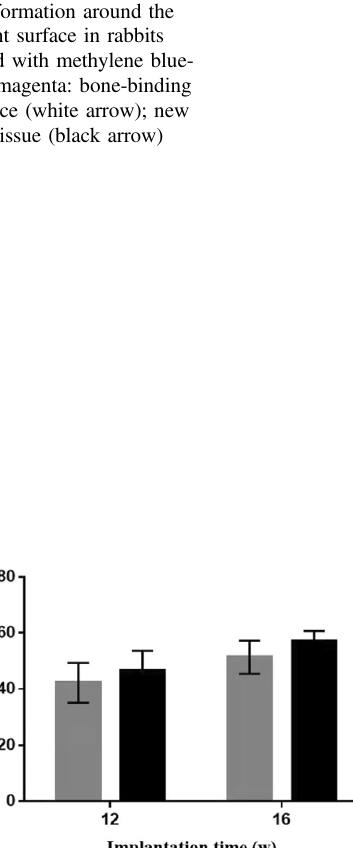
Fig. 13 Histological signs of bone formation around the implant surface in rabbits stained with methylene blue- basic magenta: bone-binding interface (white arrow); new bone tissue (black arrow)